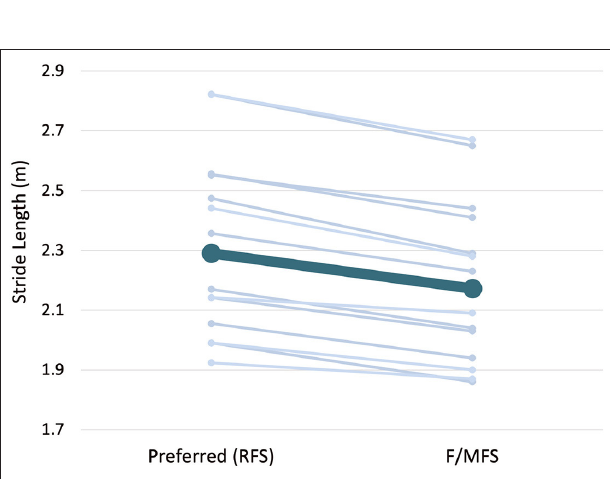
FIGURE 3 | Preferred vs. self-selected stride length (SSSL) when adopting a